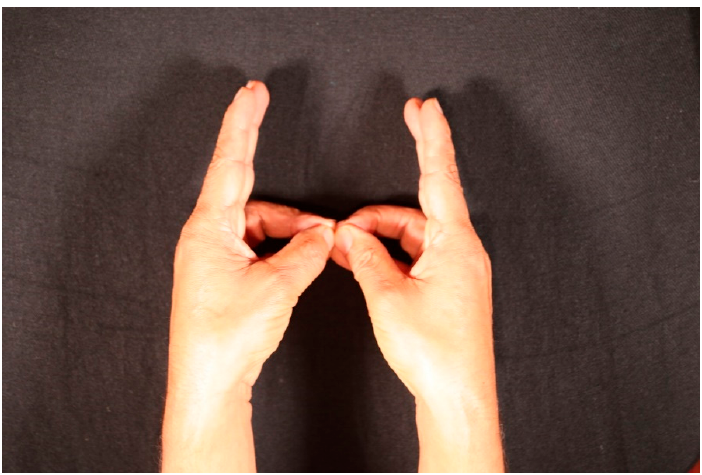
Figure 5. Yoni-Mudr ā . Figure 5. Yoni-Mudr¯a.